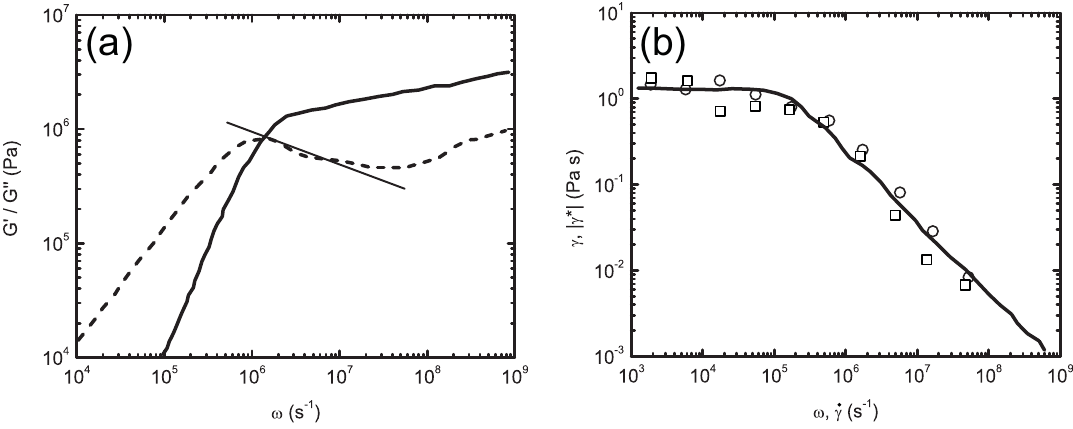
Figure 15. ( a ) Storage, G (cid:48) , and loss, G (cid:48)(cid:48) , moduli and ( b ) the flow curve, viscosity, η , versus shear rate, ˙ γ , for PE (C H ) at 450 K. In ( a ), the slope of the straight, solid line is 800 1602 ≈ -0.25. In ( b ), the solid curve is extracted from the equilibrium simulations, according to the Cox-Merz rule, while the circles and squares are measured in shear simulations through linear background and variable flow field, respectively. Figures reproduced with permission from